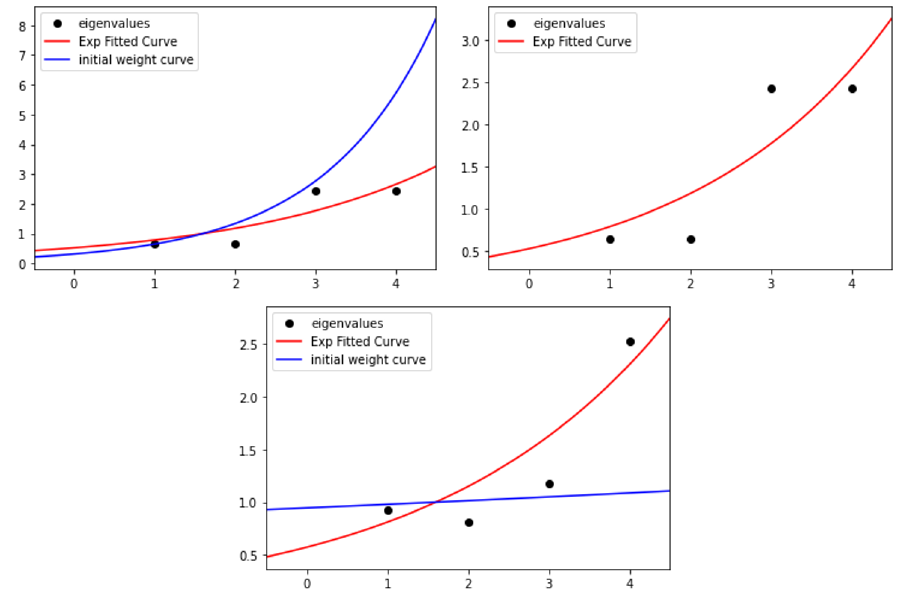
Figure 3 . Two bad fits from L 26 ( k = 100) (top left and right) and L 24 ( k = 100) (bottom). The top left and right graphs are for the same solution, and the right graph shows only the eigenvalues and the fitted curve in order to better illustrate the bad fit. As a comparison, the fit loss of the top graph was larger than 70% of the respective random losses found in section